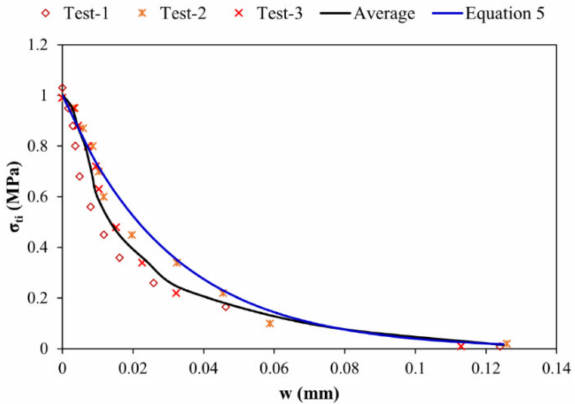
Figure 15. σ -w law for calibrated model and experimental results.